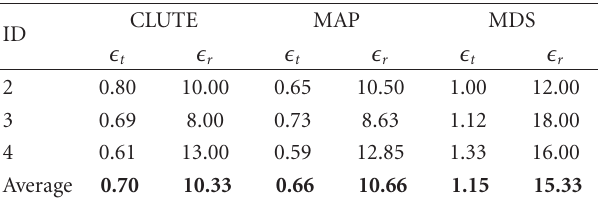
Table 5: The rotation (in degrees) and translation (in meters) errors of CLUTE for real